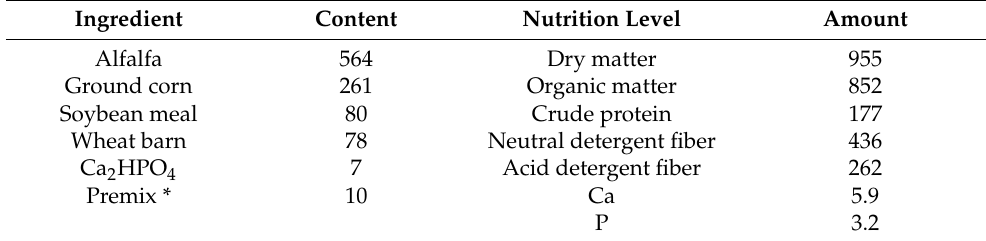
Table 1. Composition and nutritional levels (g/kg) of the basal diet. Ingredient Content Nutrition